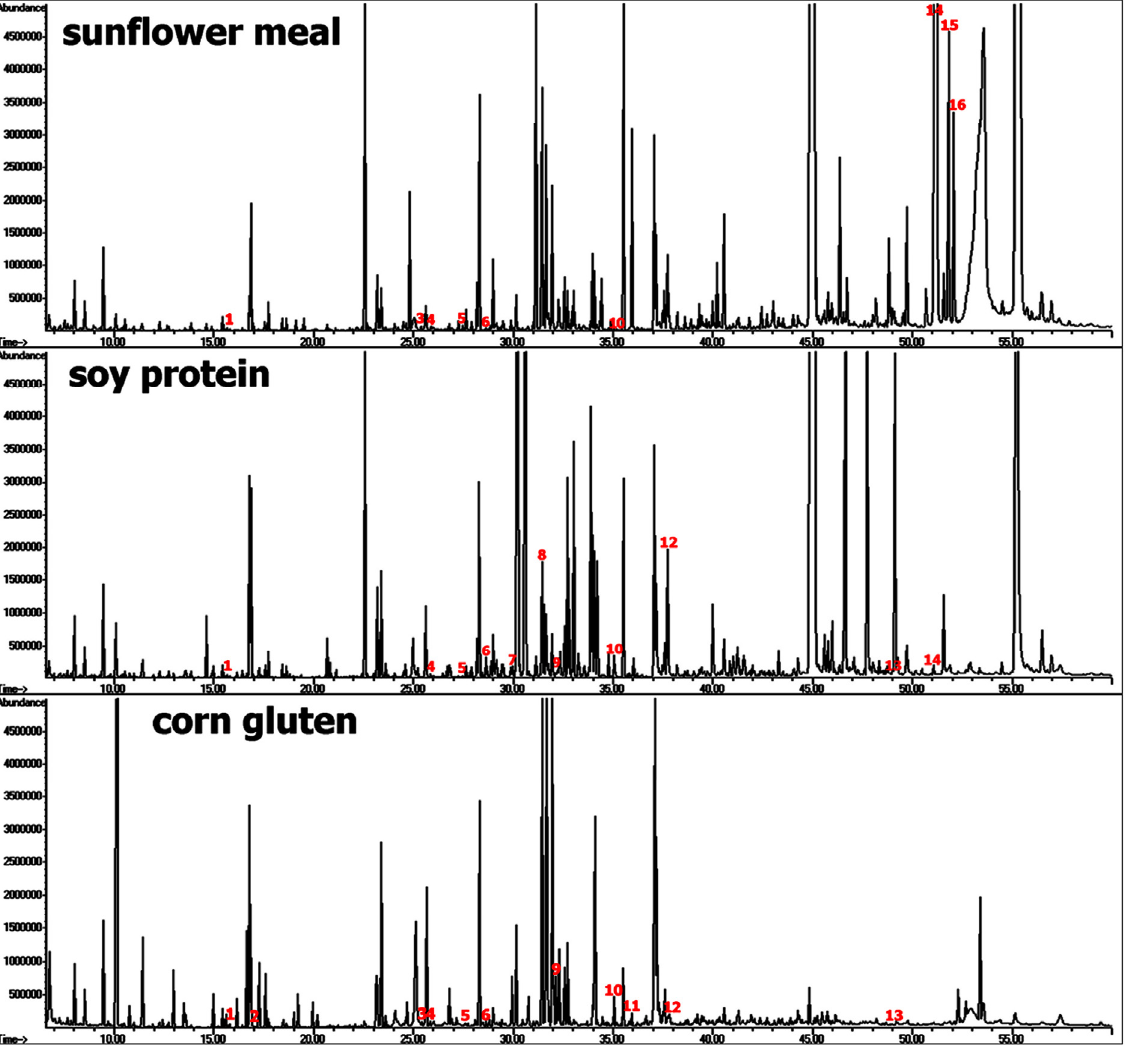
Figure 10. GC-MS-based metabolite profiling for the detection of phenolics and